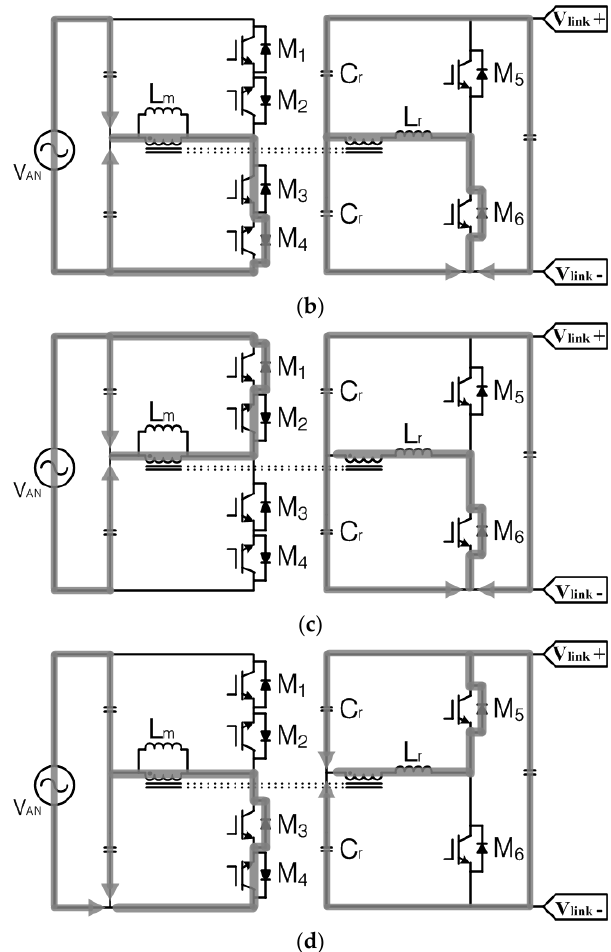
Figure 4. Current path of AC–DC converter in forward power flow: ( a ) Mode 1: positive input voltage (M1: on, M2: on, M5: on); ( b ) Mode 2: positive input voltage (M3: on, M4: on, M6: on); ( c ) Mode 3: negative input voltage (M1: on, M2: on, M6: on); ( d ) Mode 4: negative input voltage